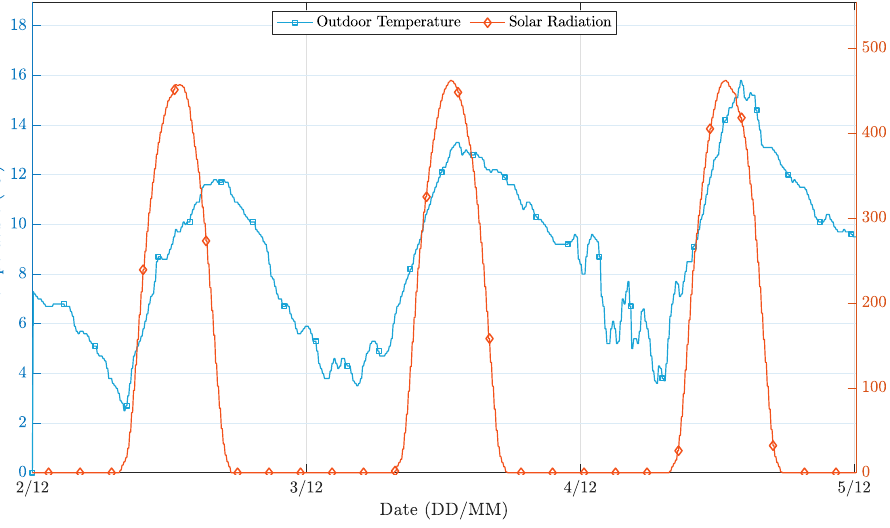
Figure 7. External environment conditions during the simulation